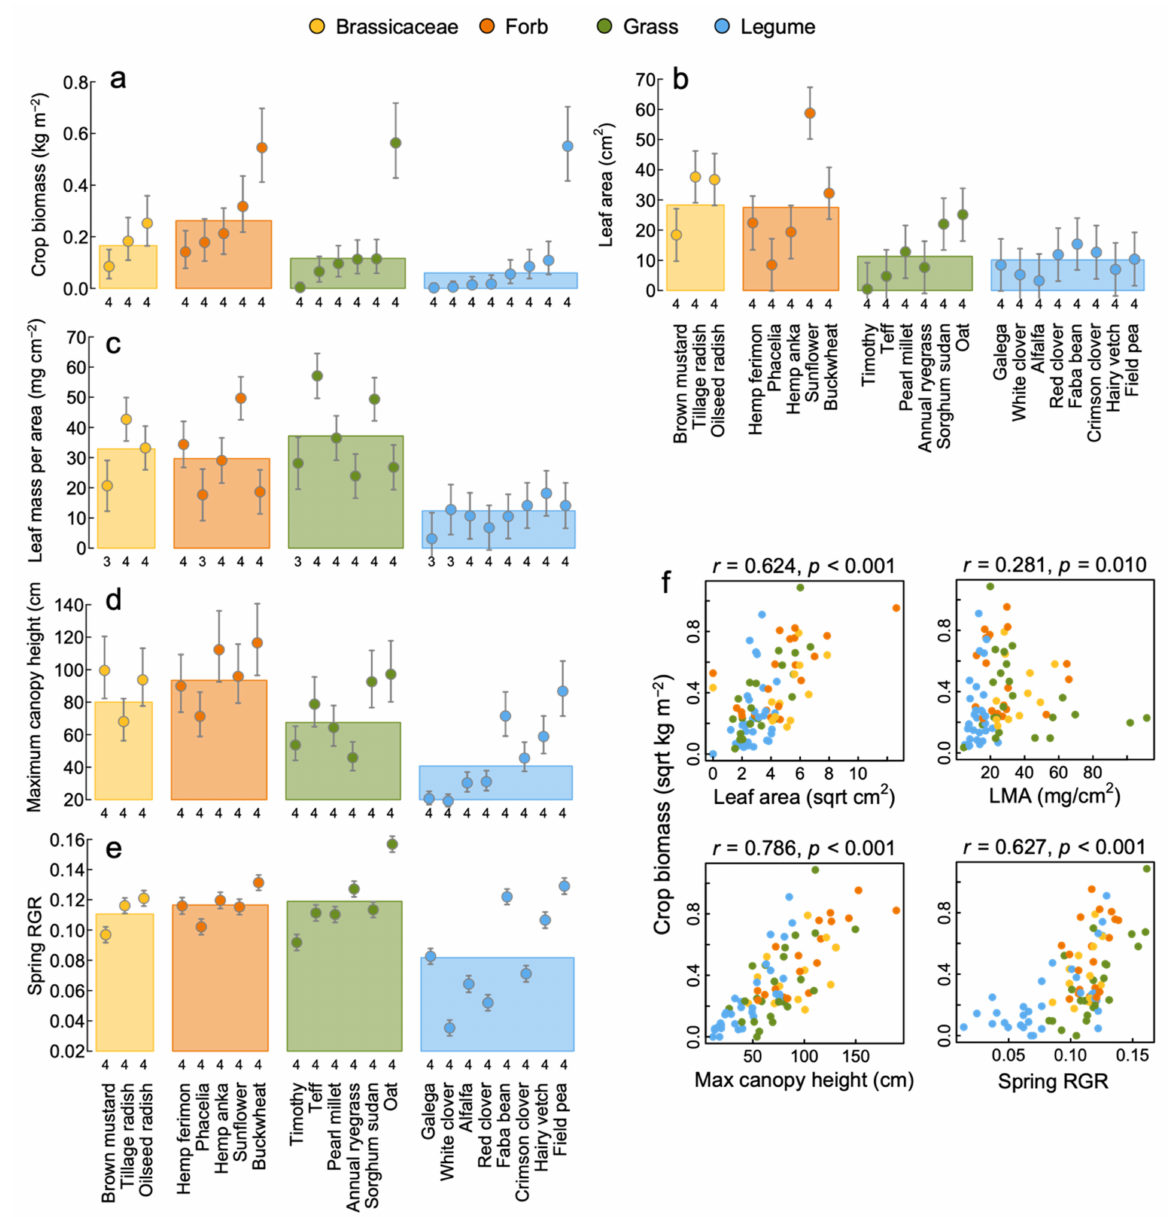
Figure 1. Crop aboveground biomass production ( a ) and the functional traits ( b ) leaf area, ( c ) leaf mass per area, ( d ) maximum canopy height and ( e ) spring relative growth rate (RGR). Points show means, and error bars are model estimates of standard errors for comparison among means of the crops. Numbers below each mean are the number of replicates included. The colored bars show the mean for each plant functional group (indicated by the different colors). Statistics are provided in Table 2. Significant correlations (Spearman) between crop biomass production and plant traits are shown ( f ). The association with rooting density is not shown as it was unrelated to crop biomass ( r = 0.148, p =